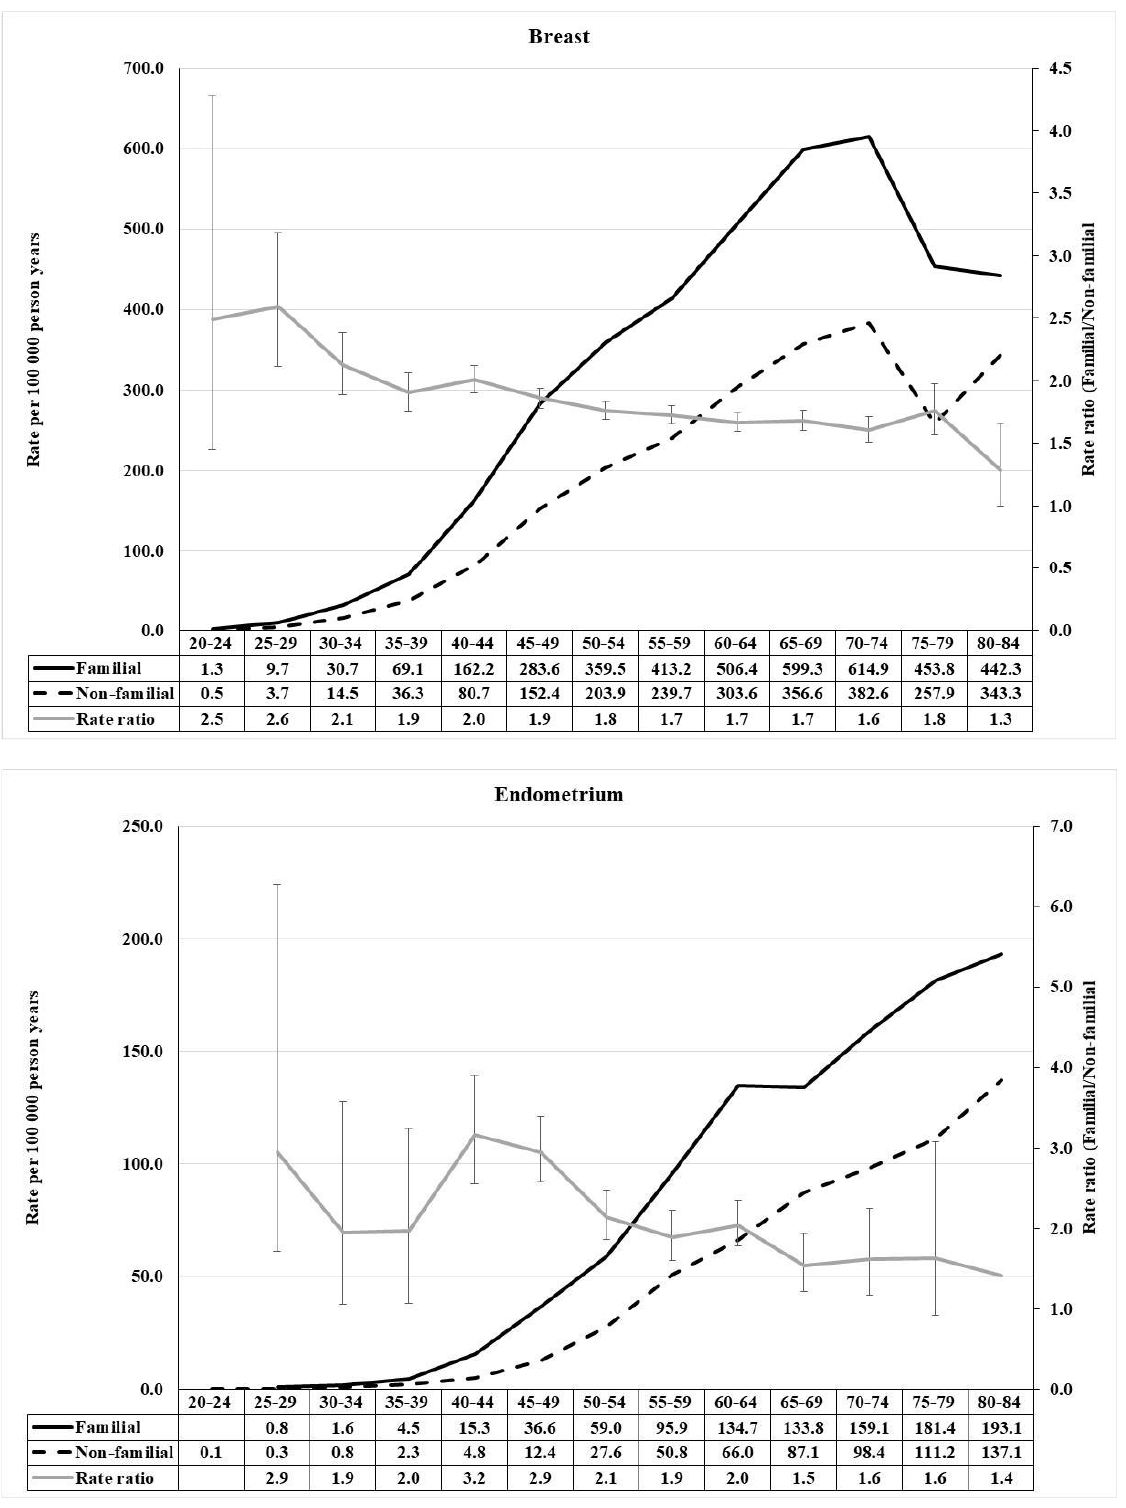
Figure 3. Age-specific incidence rate and rate ratio of female breast ( upper ) and endometrium ( lower ) cancer in population with and without family history of concordant cancer.